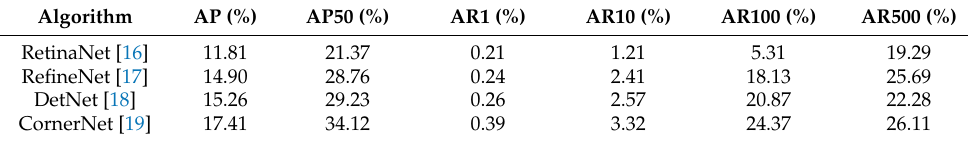
Table 4. Analysis of New Small Object Detection Algorithms in VisDrone-DET2021 Table 3. Performance for Different Input Combinations of Refinement Network.